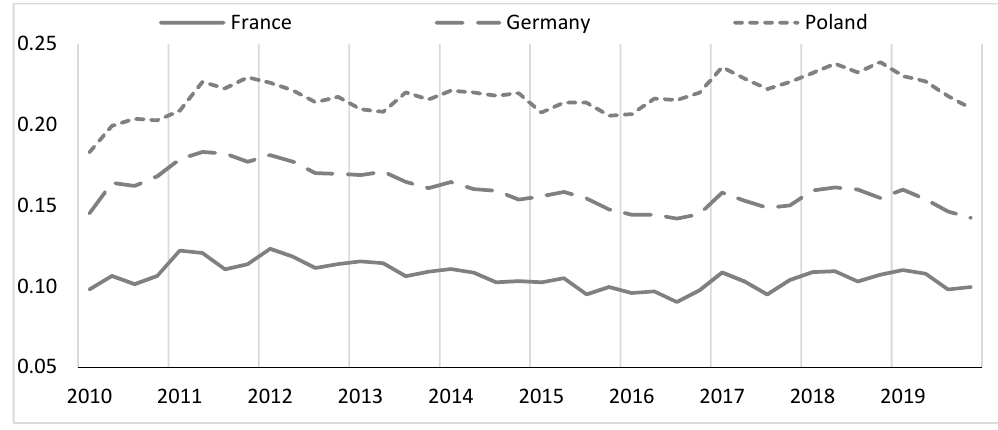
Figure 7. Import intensity of export.